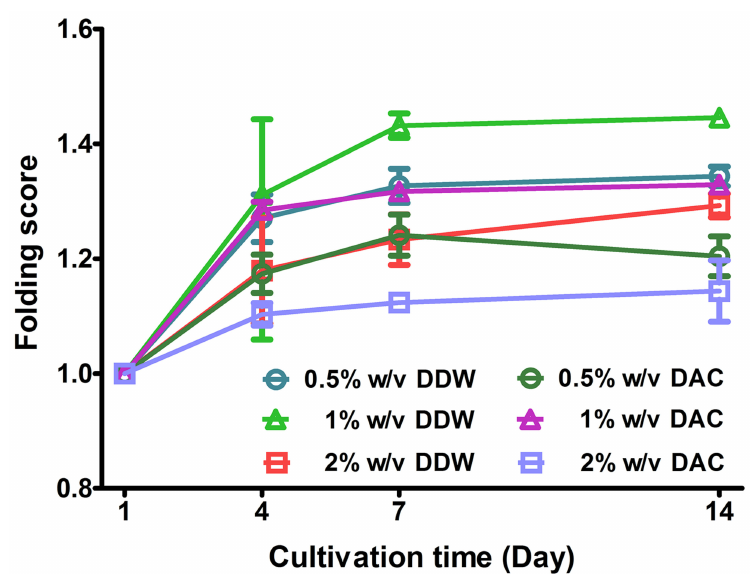
Figure 11. Proliferation of adipose-derived stem cells on porous scaffolds. The folding score at day 1, 4, 7 and 14 was normalized against the cells at day 1.